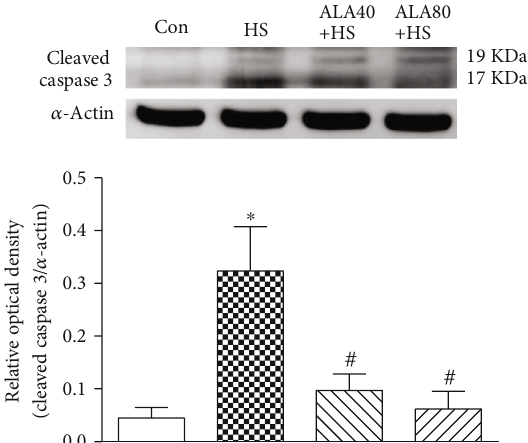
Figure 4: E ff ects of pretreatment with α -lipoic acid (ALA) on cleaved caspase 3 protein expression in the myocardium of heat stroke rats. Data are expressed as mean ± SEM ( n = 5 -8). ∗ P < 0 : 05 versus Con; # P < 0 : 05 versus